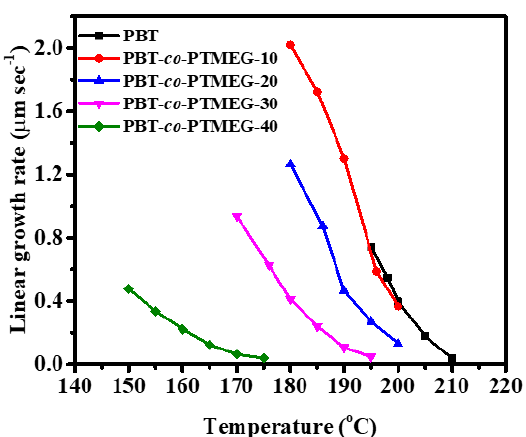
Figure 13. Spherulite growth rates as a function of crystallization temperature for PBT and PBT- co -